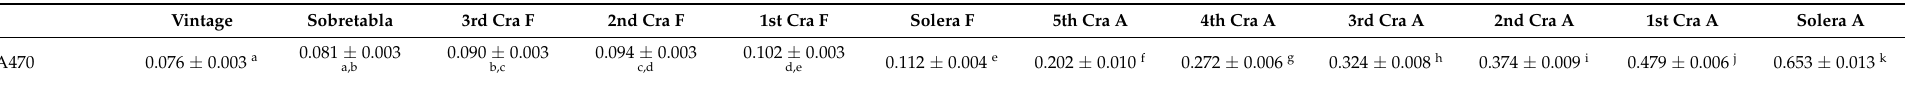
Table 8. Absorbance values at 470 nm (a.u.), related to the brownish-yellow/brownish tone, in the Sobretabla, Fino and Amontillado wines